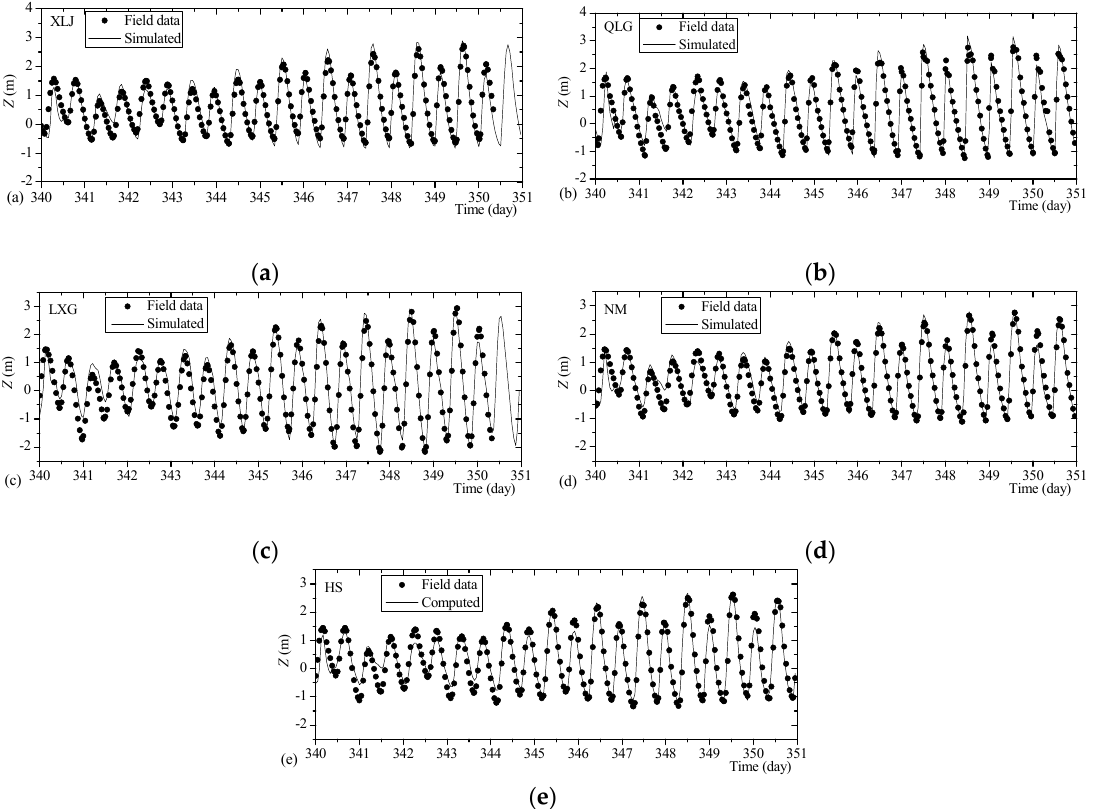
Figure 4. Comparisons of the simulated tide-level histories and field data. ( a ) at Station Xuliujing (XLJ), ( b ) at Station Qinglonggang (QLG), ( c ) at Station Lianxingang (LZG), ( d ) at Station Nanmen (NM), ( e ) at Station Hengsha (HS).